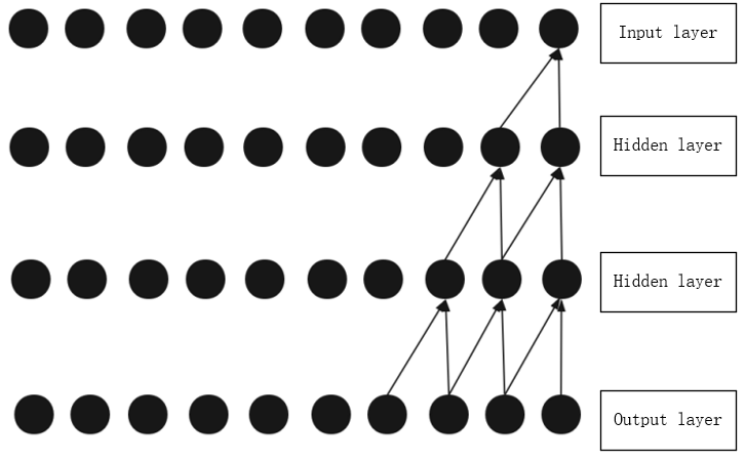
Figure 8. A schematic diagram of causal